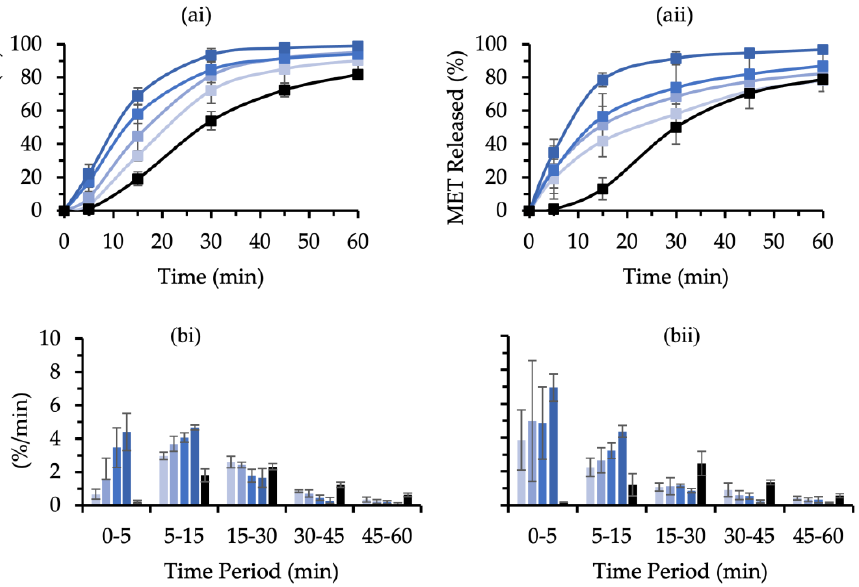
Figure 6. ( a ) MET released over time and ( b ) MET release-rate values per time period for ( i ) MCC and ( ii ) XPVP pellets compacted at 10 ( (cid:4) ), 20 ( (cid:4) ), 30 ( (cid:4) ), and 40 MPa ( (cid:4) ). Uncompacted pellets ( (cid:4) ) acted as control. Error bars indicate the standard deviation, and significant differences were omitted for clarity ( n = 4).